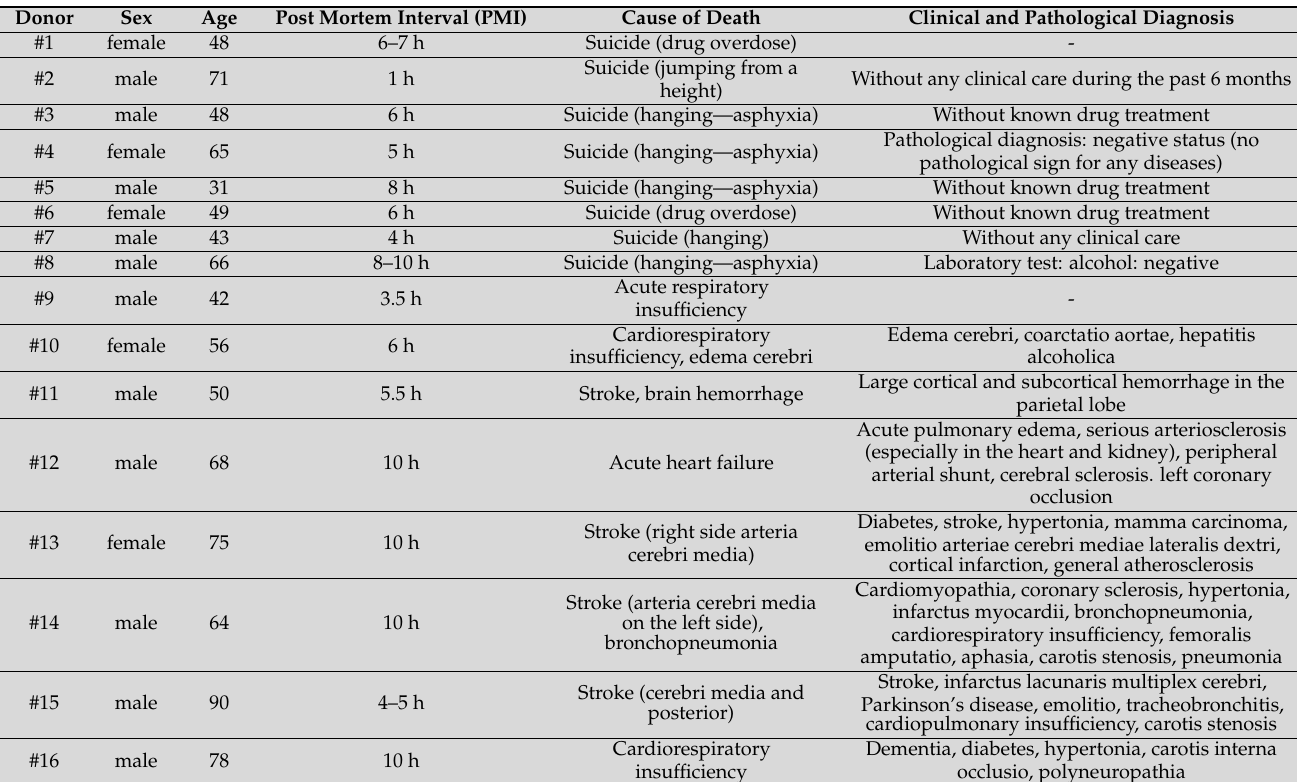
Table 3. Demographic data of